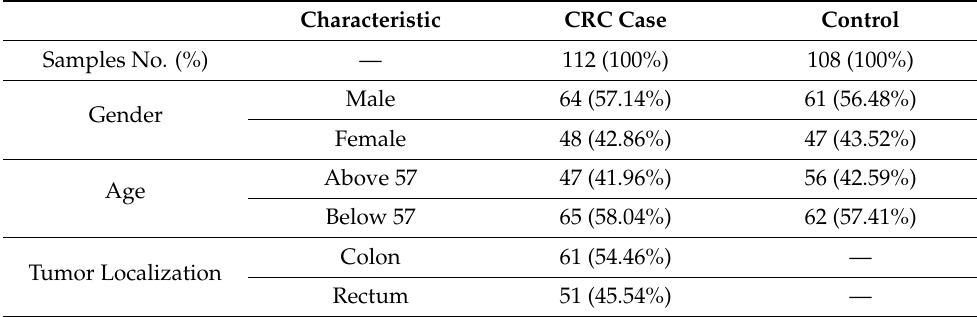
Table 3. Clinical Characteristic of the study patients.